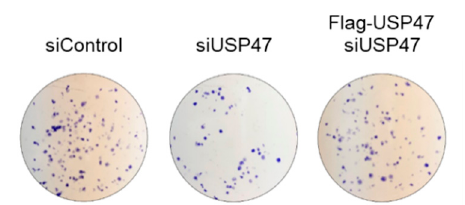
Figure 6. Suppression of USP47 inhibits cancer growth in vitro. ( a–c ) A549, U2OS, and H1299 cells were transfected with siRNA against control or USP47. ( a ) Then, cell lysates were immunoblotted with the indicated antibodies. ( b ) Cell viability was measured using EX-Cytox assay kit. Data from three independent experiments represented by mean ± SD (* p < 0.05, ** p < 0.005, t -test). ( c ) Colony formation assay was performed by re-seeding cells after 48 h transfection and then fixed and stained with crystal violet after 10 days. ( d ) Colony formation assay was performed in HCT116 p53 +/+ and p53 − / − cell lines transfected with negative control or USP47 siRNA. Cells were re-seeded after 48 h and then fixed and stained with crystal violet after 10 days. ( e , f ) A549 cells were overexpressed with Flag-USP47 for 24 h and then transfected with siRNA against control or USP47 for 48 h. ( e ) Cell lysates were immunoblotted with the indicated antibodies. ( f ) Colony formation assay was performed by re-seeding cells after 48 h transfection and then fixed and stained with crystal violet after 10 days. The uncropped blots and molecular weight markers are shown in Figure S7.